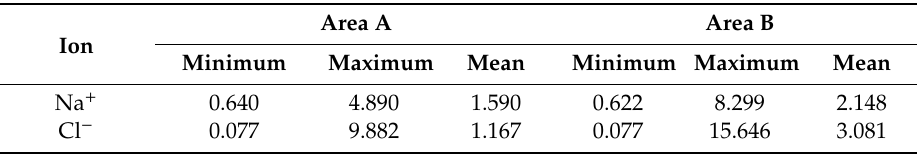
Table 2. Descriptive statistics of Na + and Cl − ion contents (unit: g /